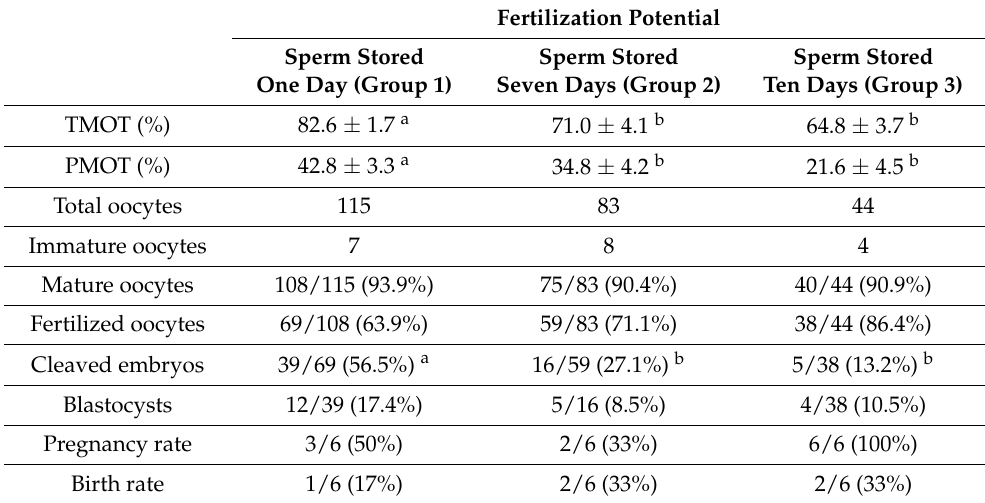
Table 2. Percentage of motile sperm, in vitro success rates after fertilization oocytes, and artificial insemination rates in hinds inseminated ( n = 18) with liquid-stored epididymal sperm of red deer. Fertilization Potential Sperm Stored Sperm Stored Sperm Stored One Day (Group 1) Seven Days (Group 2) Ten Days (Group 3) TMOT (%) 82.6 ± 1.7 a 71.0 ± 4.1 b 64.8 ± 3.7 b PMOT (%) 42.8 ± 3.3 a 34.8 ± 4.2 b 21.6 ± 4.5 b Total oocytes 115 83 44 Immature oocytes 7 8 4 Mature oocytes 108/115 (93.9%) 75/83 (90.4%) 40/44 (90.9%) Fertilized oocytes 69/108 (63.9%) 59/83 (71.1%) 38/44 (86.4%) Cleaved embryos 39/69 (56.5%) a 16/59 (27.1%) b 5/38 (13.2%) b Blastocysts 12/39 (17.4%) 5/16 (8.5%) 4/38 (10.5%) Pregnancy rate 3/6 (50%) 2/6 (33%) 6/6 (100%) Birth rate 1/6 (17%) 2/6 (33%) 2/6